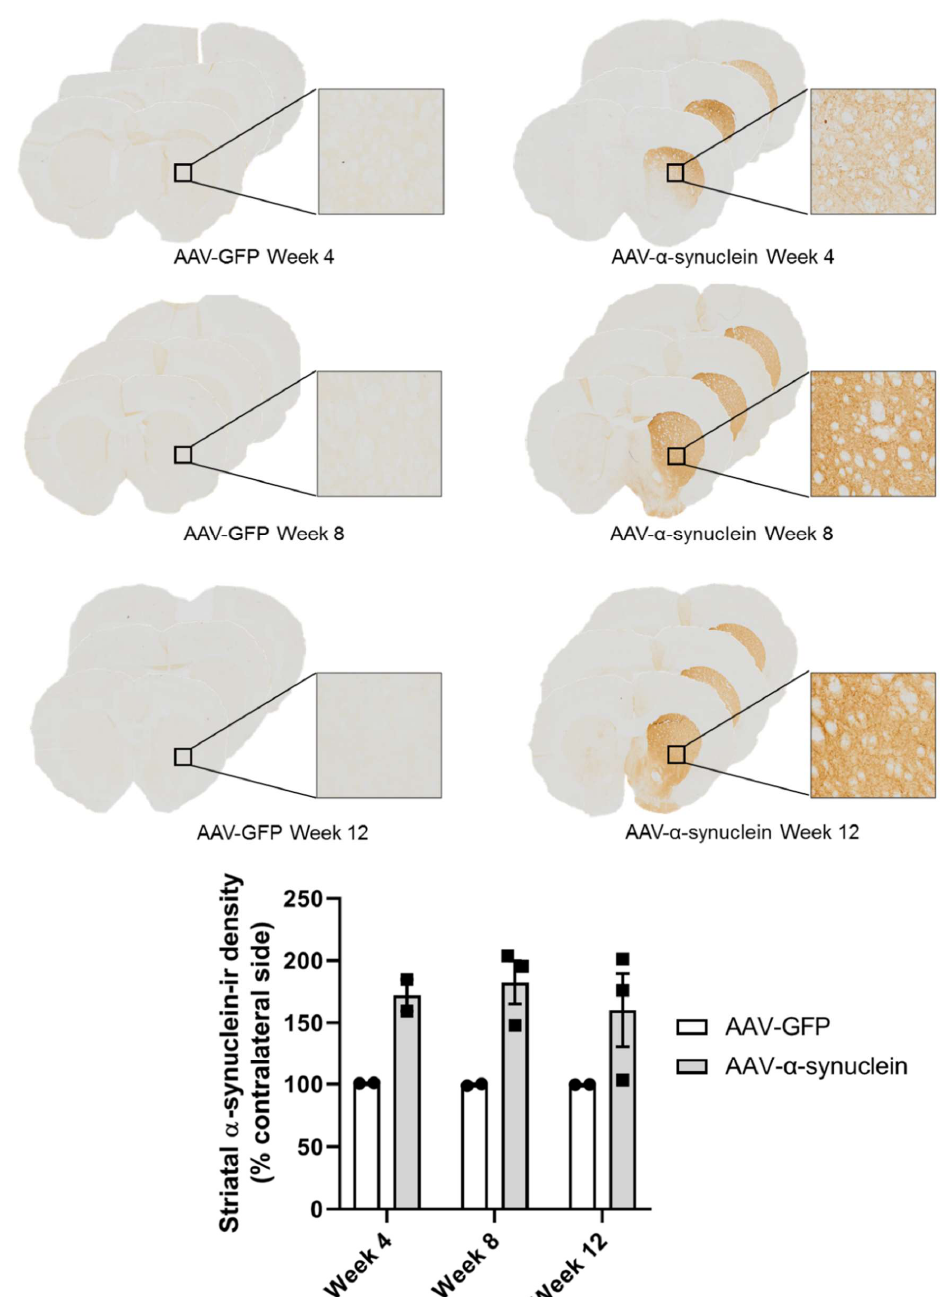
Figure 2. Expression of human α -synuclein in the striatum after injection of AAV- α -synuclein. Top panel: photomicrographs showing α-synuclein expression in the striatal terminals at different time- points after the intranigral administration of the viral vectors. Bottom panel: graph showing the relative quantification of the expression of human α-synuclein in the striatum using optical density image analyses of sections labelled by immunohistochemistry for human α-synuclein. Note that animals that received AAV-α-synuclein expressed human α-synuclein protein in the striatum, but animals that received AAV-GFP did not. Data are represented as mean ± SEM with 2–3 animals per group.